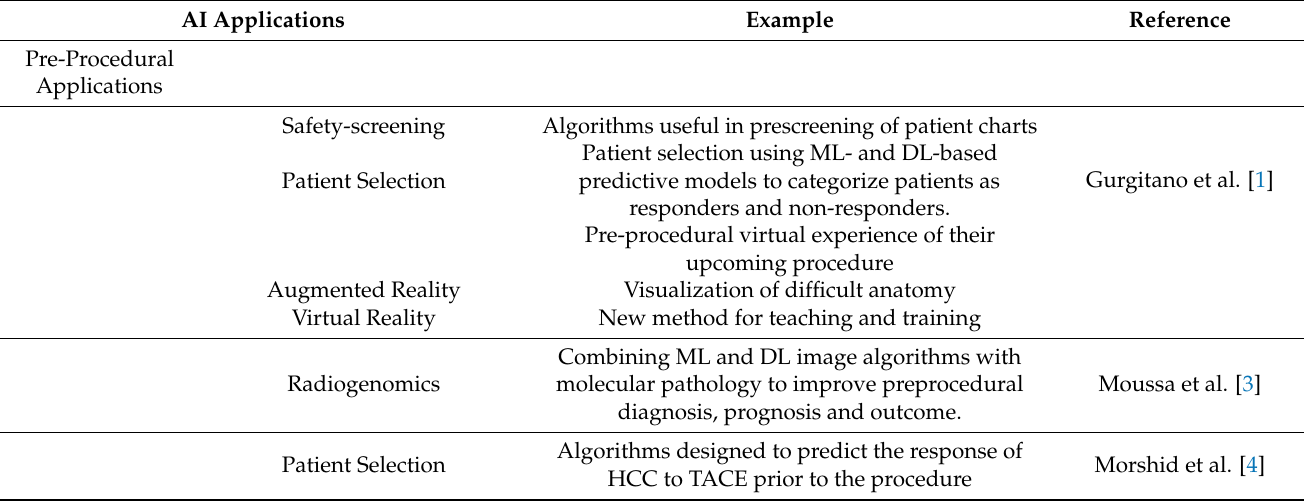
Table 1. Summary of pre-procedural, intra-procedural and post-procedural AI applications with associated examples and